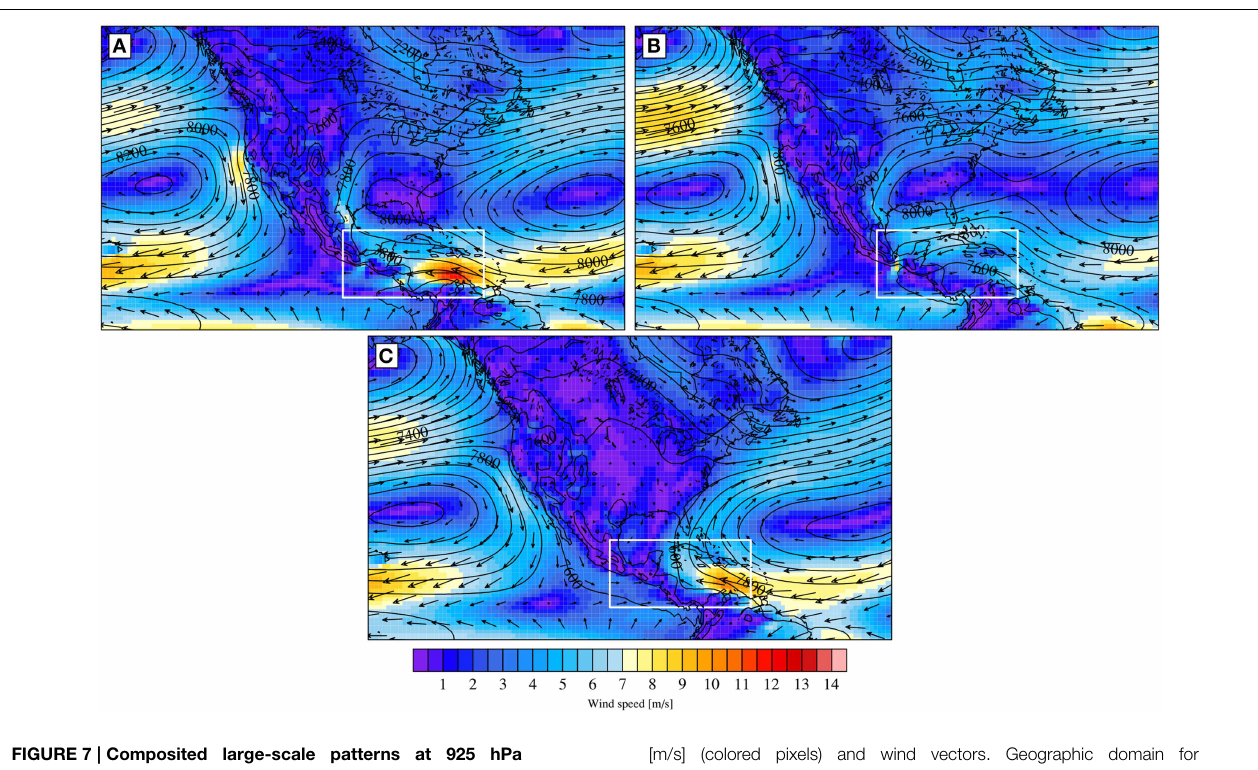
FIGURE 7 | Composited large-scale patterns at 925 hPa associated with (A) ASWW, (B) AGAD, and (C) ENAH regimes. Geopotential height [ m 2 / s 2 ] (black contours), wind speed